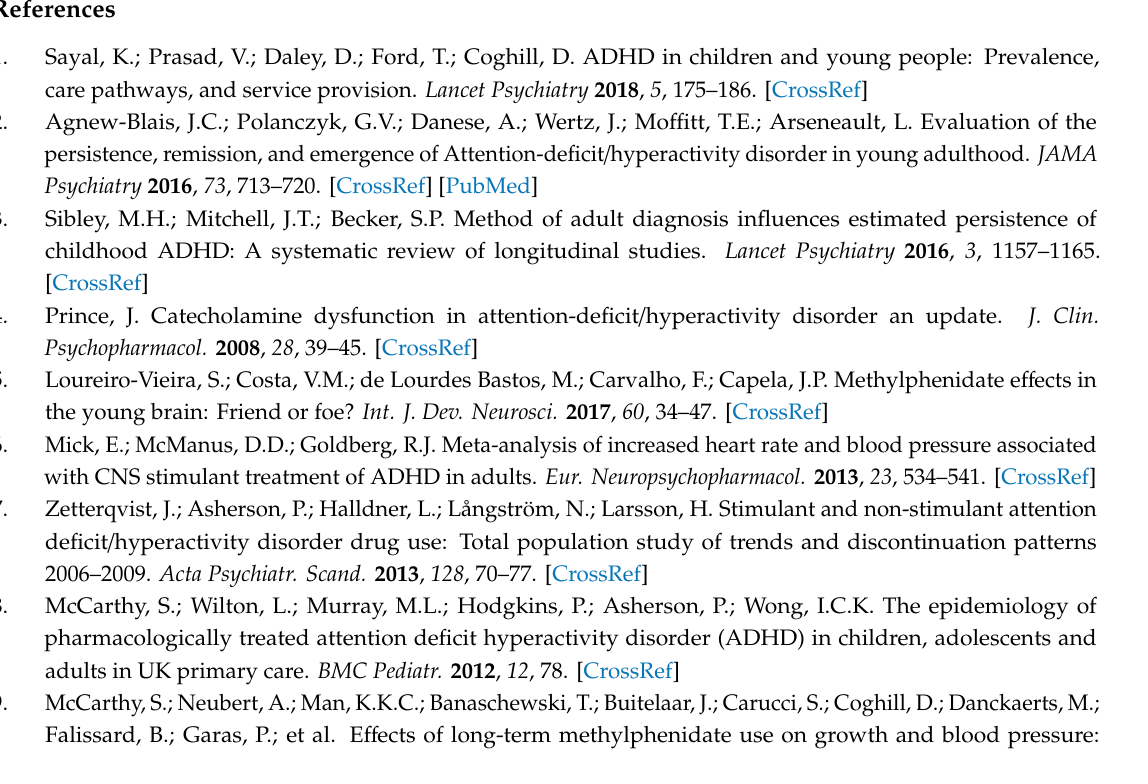
Table S1: Plasma concentrations of ADMA, arginine (Arg), nitrate, and nitrite of controls (Co) and ADHD children without ( − MPH) and with ( + MPH) methylphenidate (MPH) medication, Table S2: Age-corrected ADMA and nitrite plasma concentration (mean ± SD) in ADHD children without ( − MPH) and with ( + MPH) methylphenidate (MPH) medication, Table S3: Age-corrected ADMA (A) and nitrite (B) plasma concentration (mean adj ± SEM) in ADHD children without ( − MPH) and with ( + MPH) methylphenidate (MPH) medication according to the IQ range of 50–100 and >